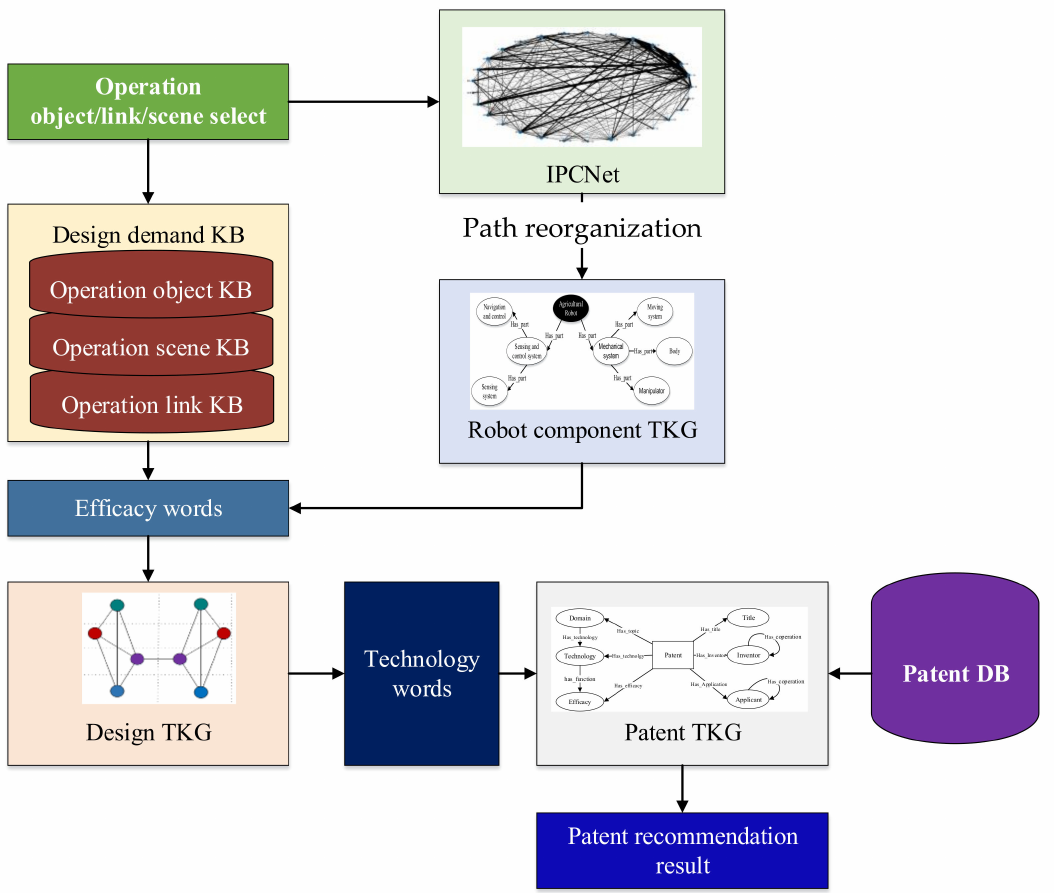
Figure 7. Technology recommendation process for agricultural robot design based on a technology efficacy